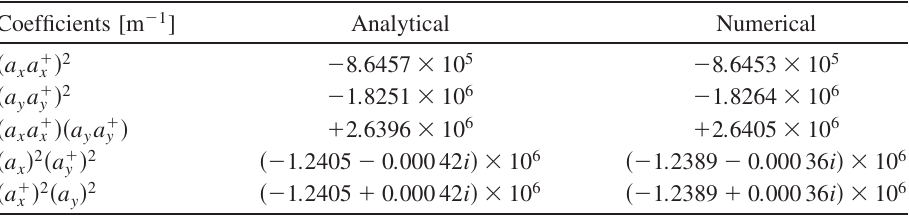
TABLE VII. The Lie factor f for two families of sextupoles in the PEP-X achromat. 4 Coefficients [ m (cid:2) 1 ] Analytical Numerical